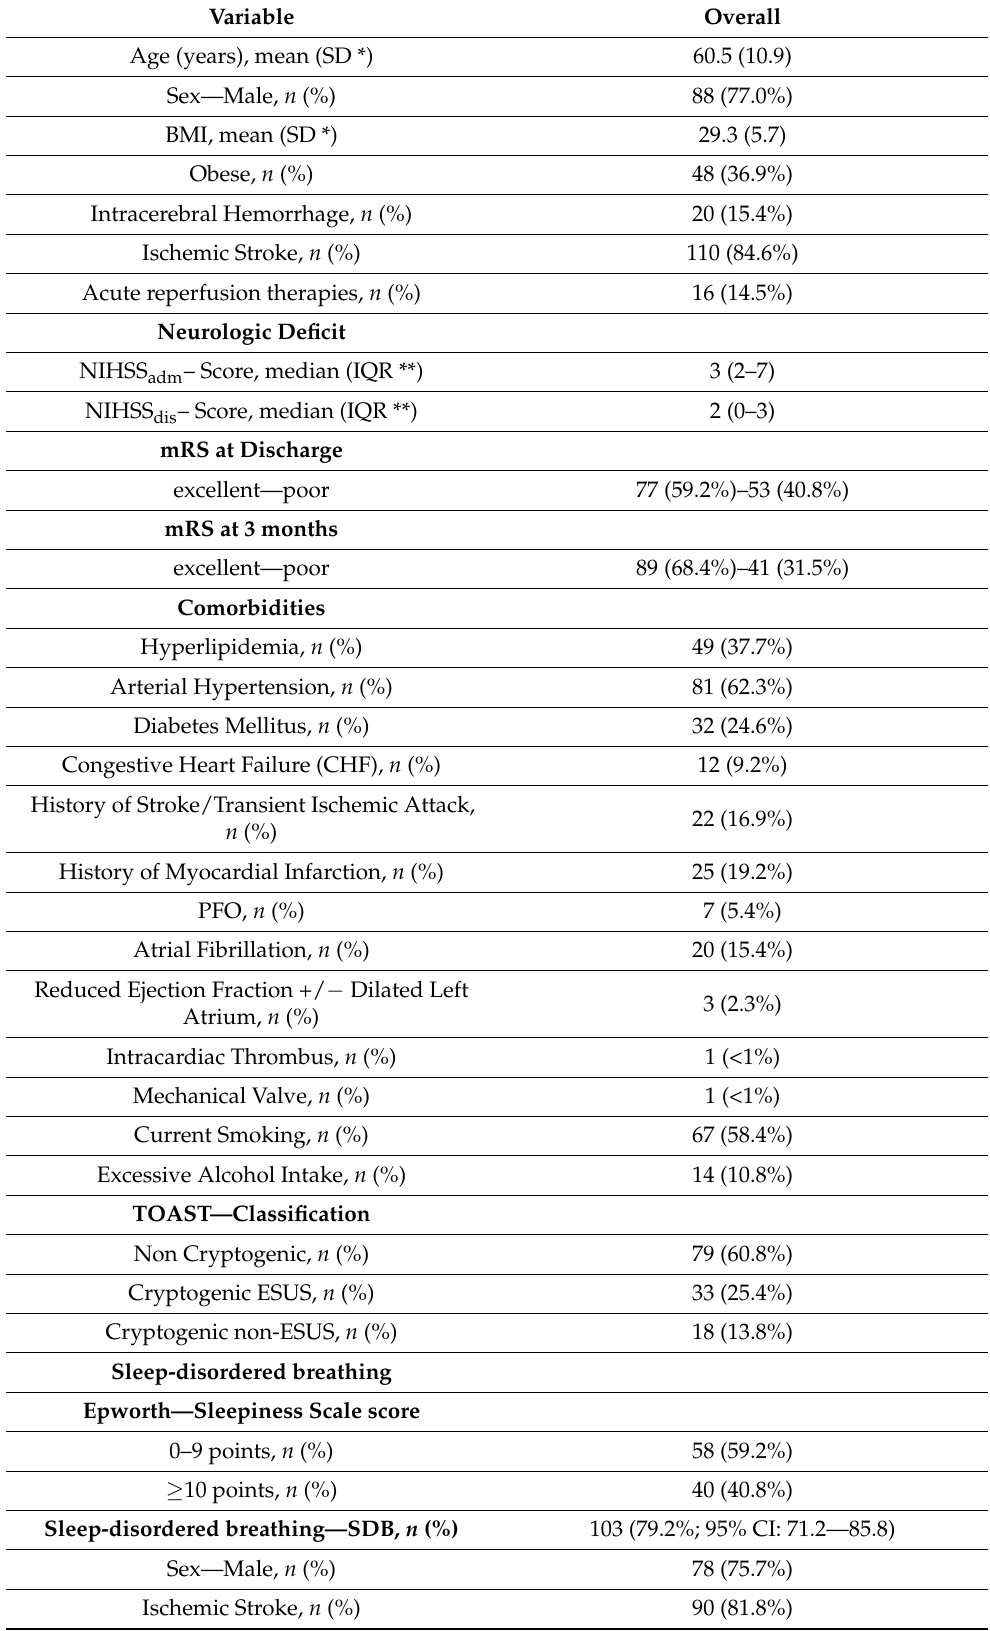
Table 1. Baseline characteristics of the study population ( n =